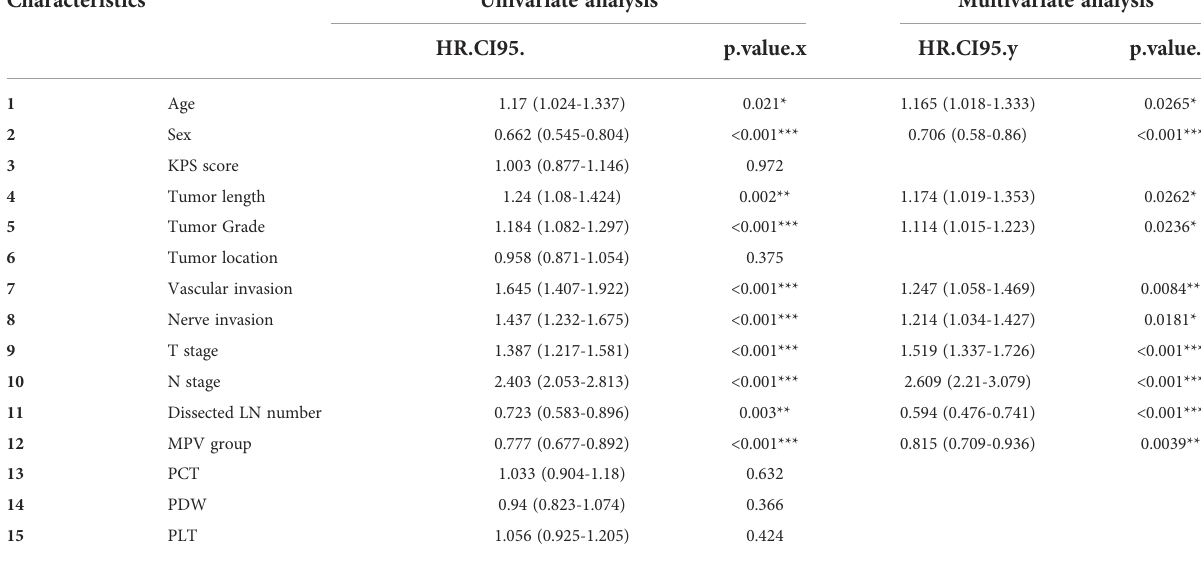
TABLE 2 Univariate and multivariate analyses of predictive factors associated with overall survival.